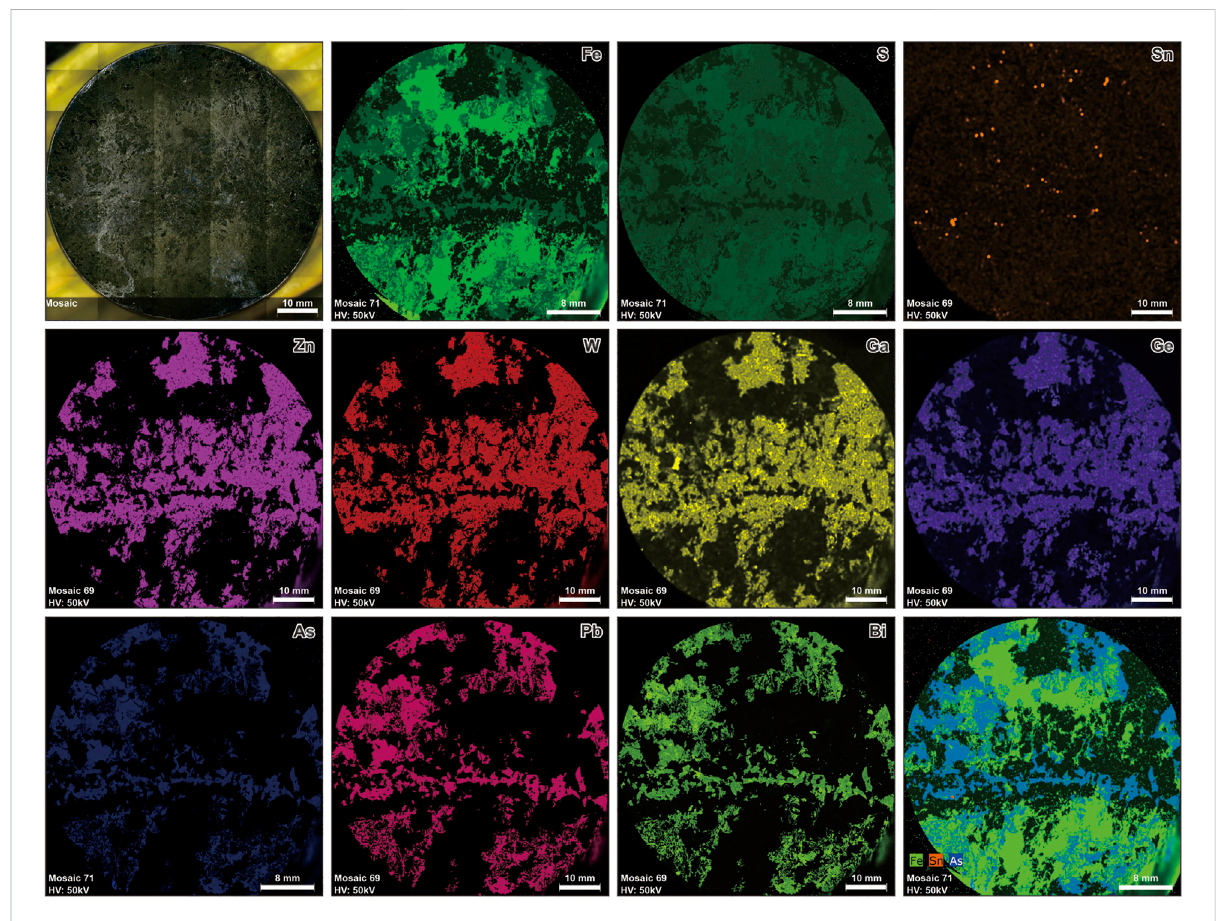
FIGURE 8 Photograph, single-element μ -XRF maps (Fe, S, Sn, Zn, W, Ga, Ge, As, Pb, Bi) and multi-element map of rock slab